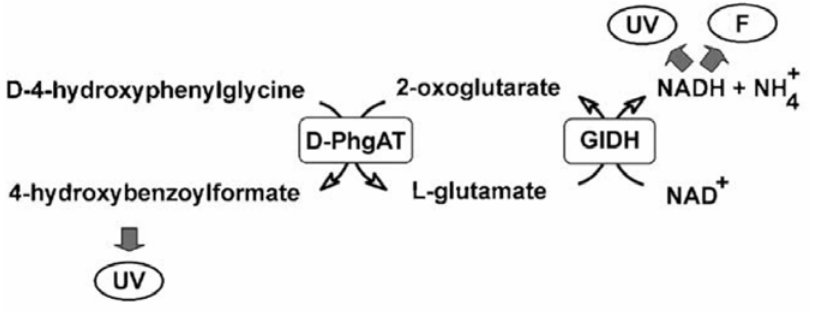
Figure 4. Enzymatic cycling for the determination of 0.4 (fluorescence) and 0.7 (UV) µM L -glutamate using GlDH and D -PhgAT. Each turn of the cycle generates one molecule each of NADH and 4- hydroxybenzoylformate, which were detected by UV absorbance at 340 nm. NADH was also detected fluorometrically ( λ ex = 340 nm, λ em = 460 nm)